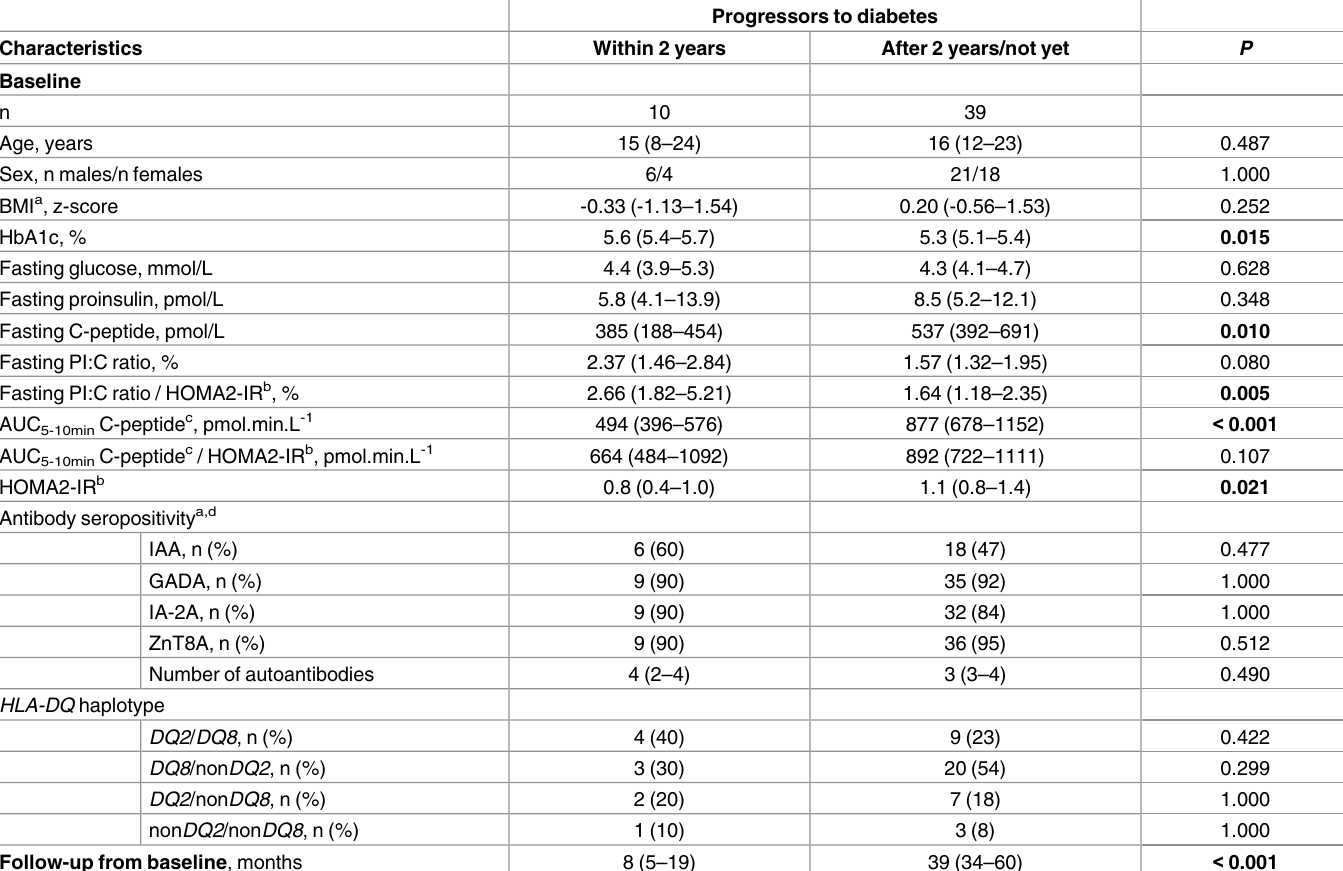
Table 2. Characteristics of relativesat high autoantibody-inferred risk (HR) (IA-2A + or ZnT8A + plus (cid:21) 1 other autoantibody) [9] according to pro- gression rate to